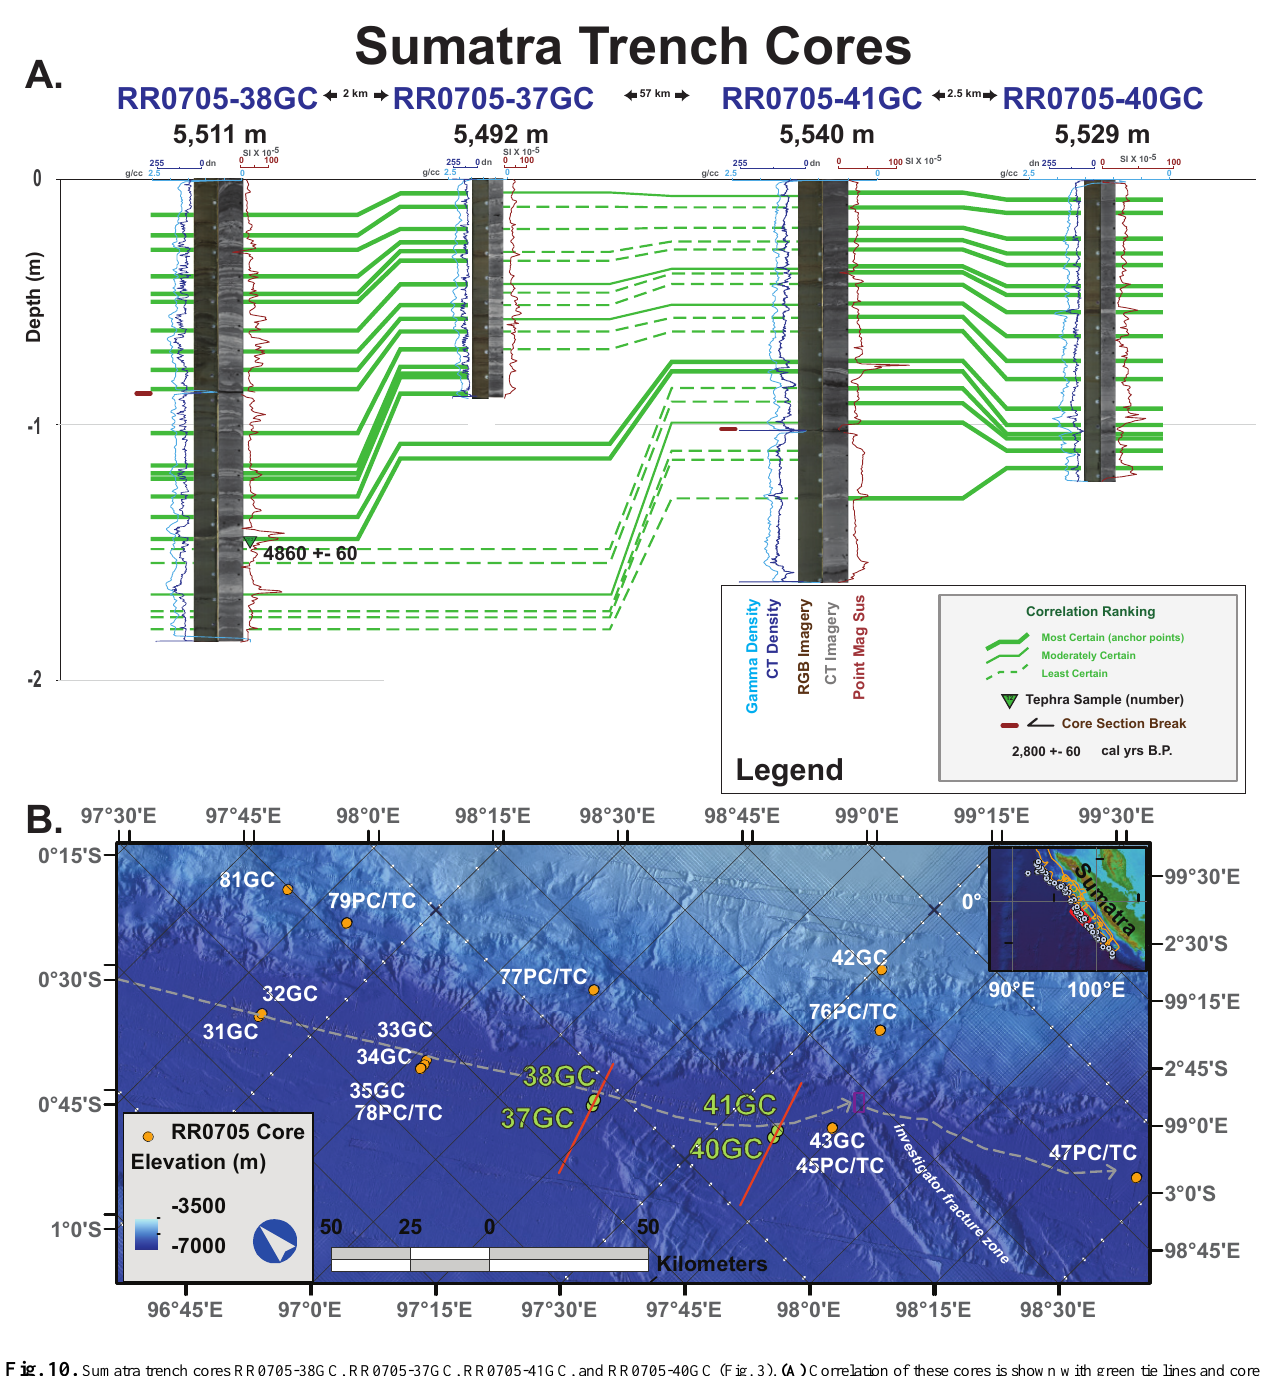
Fig. 10. Sumatra trench cores RR0705-38GC, RR0705-37GC, RR0705-41GC, and RR0705-40GC (Fig. 3). (A) Correlation of these cores is shown with green tie lines and core data are plotted with the same configuration as Fig. 2. The radiocarbon age is from hemipelagic sediment underlying the correlated tephra in core 79PC and reported with 95% error (Salisbury et al., 2012; Table S1). (B) Core location map with cores plotted as orange circles over multibeam bathymetry, cores 37, 38, 40, and 41 in green (Ladage et al., 2006). Inset map shows location of large map in red (central margin). Dashed grey line shows general trench axis as a potential flow pathway. Purple rectangle shows where the IFZ intersects the trench to isolate these basins (flow pathway